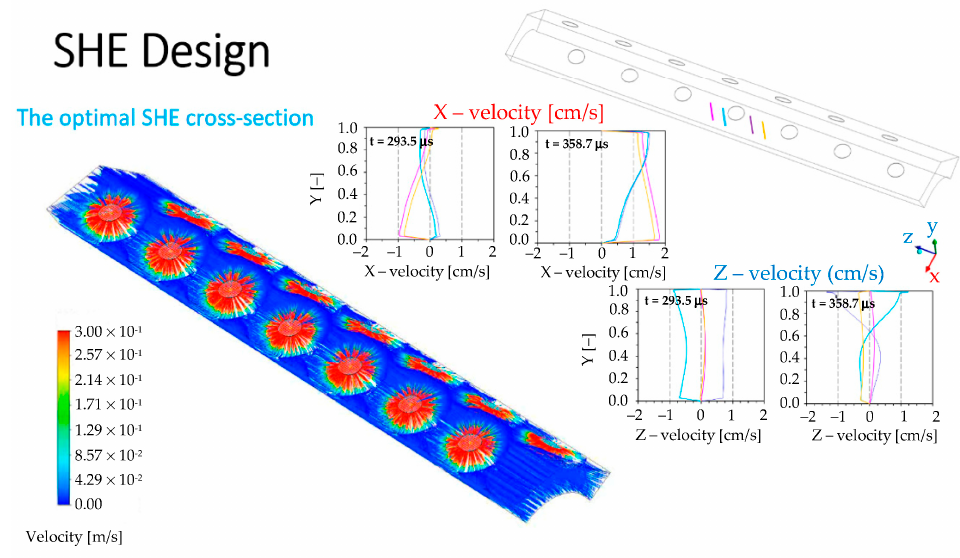
Figure 6. Fluid dynamic analysis of the olive paste inside the Sono-Heat-Exchanger—Olive Sound.